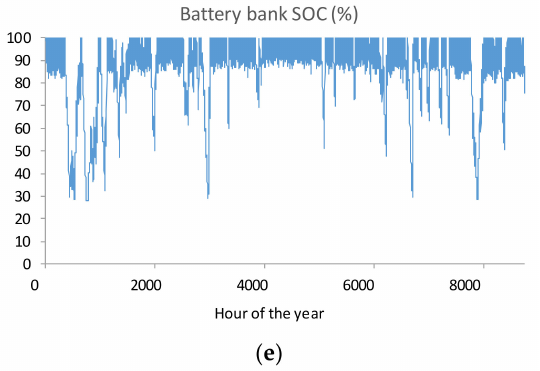
Figure 5. Hourly simulation of the Pyrenees—lead-acid battery: load (W) ( a ), PV generation (W) ( b ),